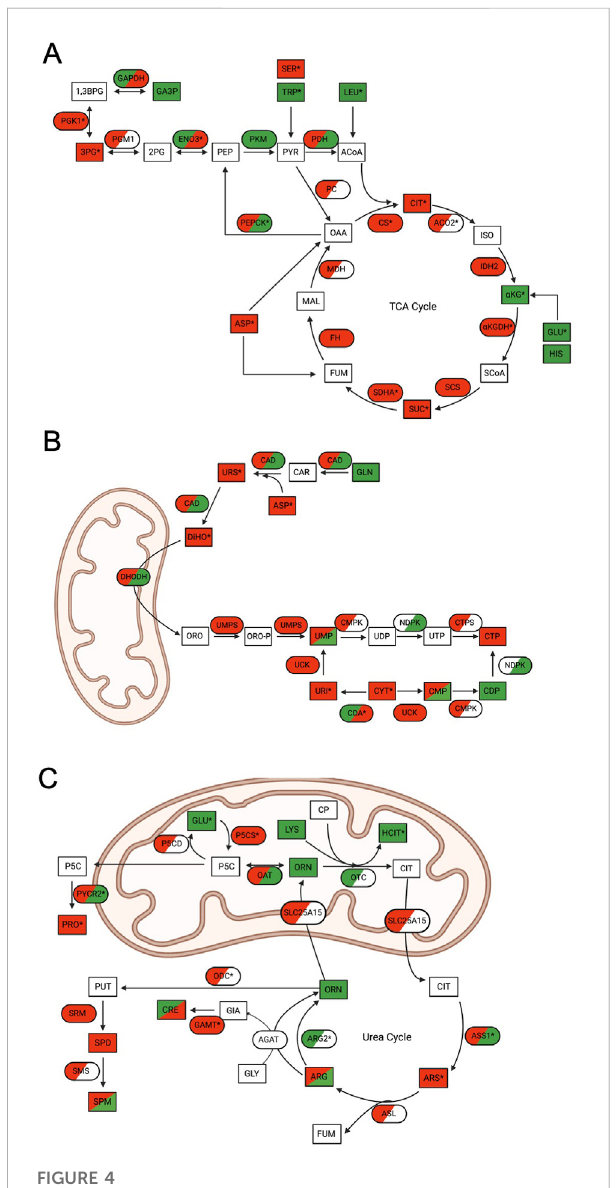
Multi-omics analysis reveals signi fi cant mitochondrial metabolic pathway perturbations following ONC201 or TR-57 treatment in SUM159 cells. In all schematics, rectangles represent metabolites and ovals represent enzymes. Directionality of change is indicated by color (downregulation (red), upregulation (green), not detected (white)) and * denotes signi fi cant change in at least one dataset. Dual- coloredenzymesrepresentthosewithdifferentdirectionalchangesin proteomics (left side) and transcriptomics (right side) while dual- colored metabolites indicate different directional changes in ONC201 treatment (left side) and TR-57 treatment (right side). (A) Schematic of the tricarboxylic acid (TCA) cycle. CIT: citrate ; ISO: isocitrate ; α KG: α -ketoglutarate ; GLU; glutamic acid ; HIS: histidine ; SCoA: succinyl-CoA ; SUC: succinate ; FUM: fumarate ; MAL: malate : OAA: oxaloacetate ; ASP: aspartic acid ; ACoA: acetyl-CoA ; PYR: pyruvate ; PEP: phosphoenolpyruvate : TRP: tryptophan ; SER: serine ; LEU: leucine ; 2 PG: 2-phosphoglycerate ; 3 PG: 3-phosphoglycerate ; 1,3BPG: 1,3-bisphosphoglycerate ; GA3P: